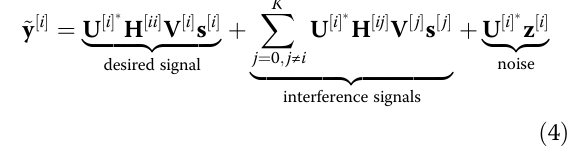
where s [ i ] is the transmission signal of the i th transmitter. From the IA condition, interference signals term of (4) is eliminated. Fig. 2, in order to eliminate dependence on the PU infor- mation in the CR system for IA. The designated sensor node should sense the primary signal continuously so that it cannot transmit or receive data during the sensing process. It may also consume